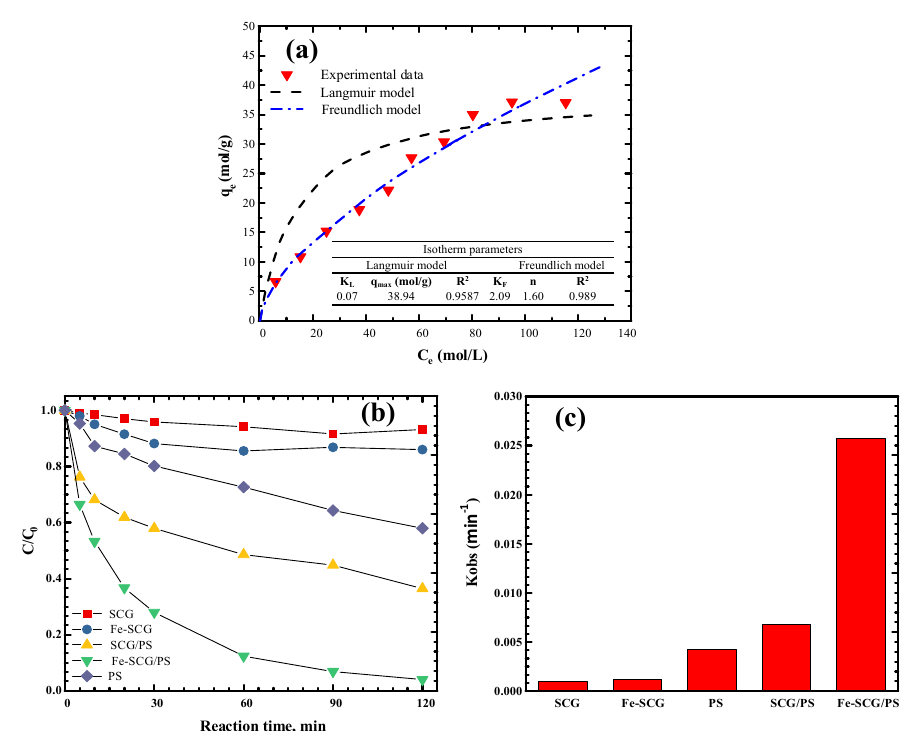
Figure 4. ( a ) Langmuir and Freundlich adsorption isotherms of Fe-SCG; ( b ) TC degradation efficiency and ( c ) degradation rate constant (K obs ) of the different processes.